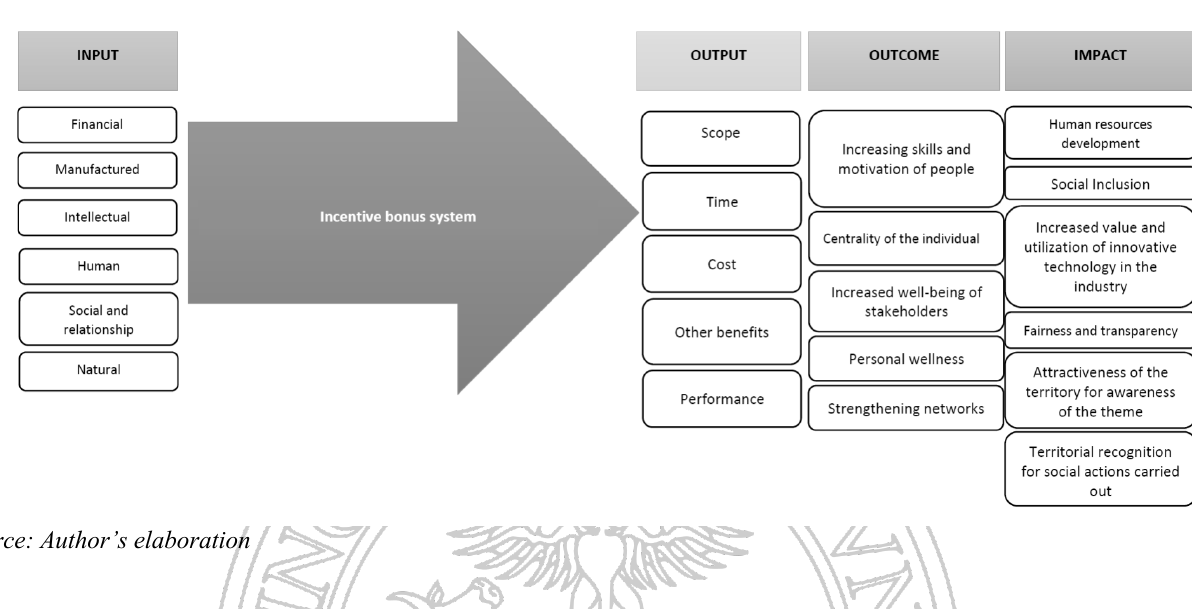
Figure 4. simplification of